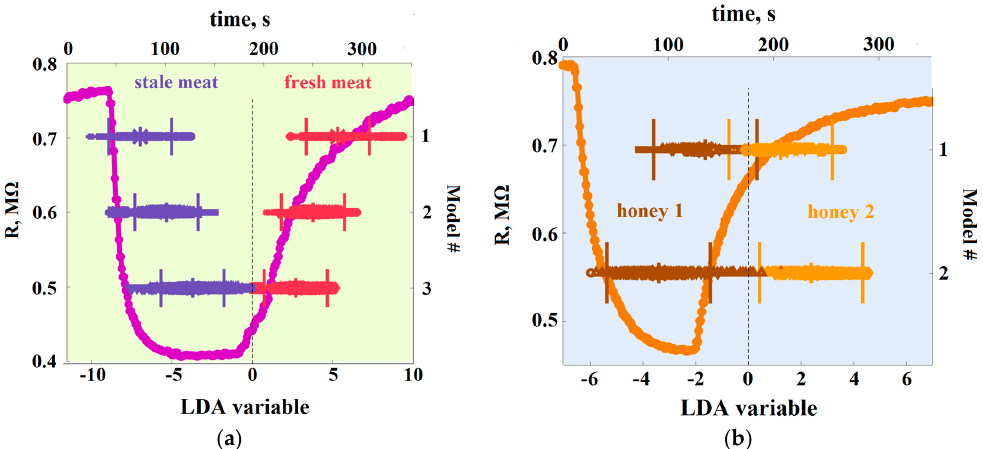
Figure 3. The results of LDA processing of the e-nose data to discriminate meat freshness ( a ) and honeys ( b ). The curves in the background show typical transitions of the resistance of exemplary sensor segment of the array during the exposures. The centers of LDA model classes are marked by asterisks symbols and the confidence intervals of 95% probability for each class are indicated with vertical bars. The meat freshness recognition models are numbered as: 1–model of the first series; 2–the second series one; 3–the combined model of both the series. The honey classes’ recognition models: 1–the samples of different harvesting times, 2–the samples of different harvesting places.